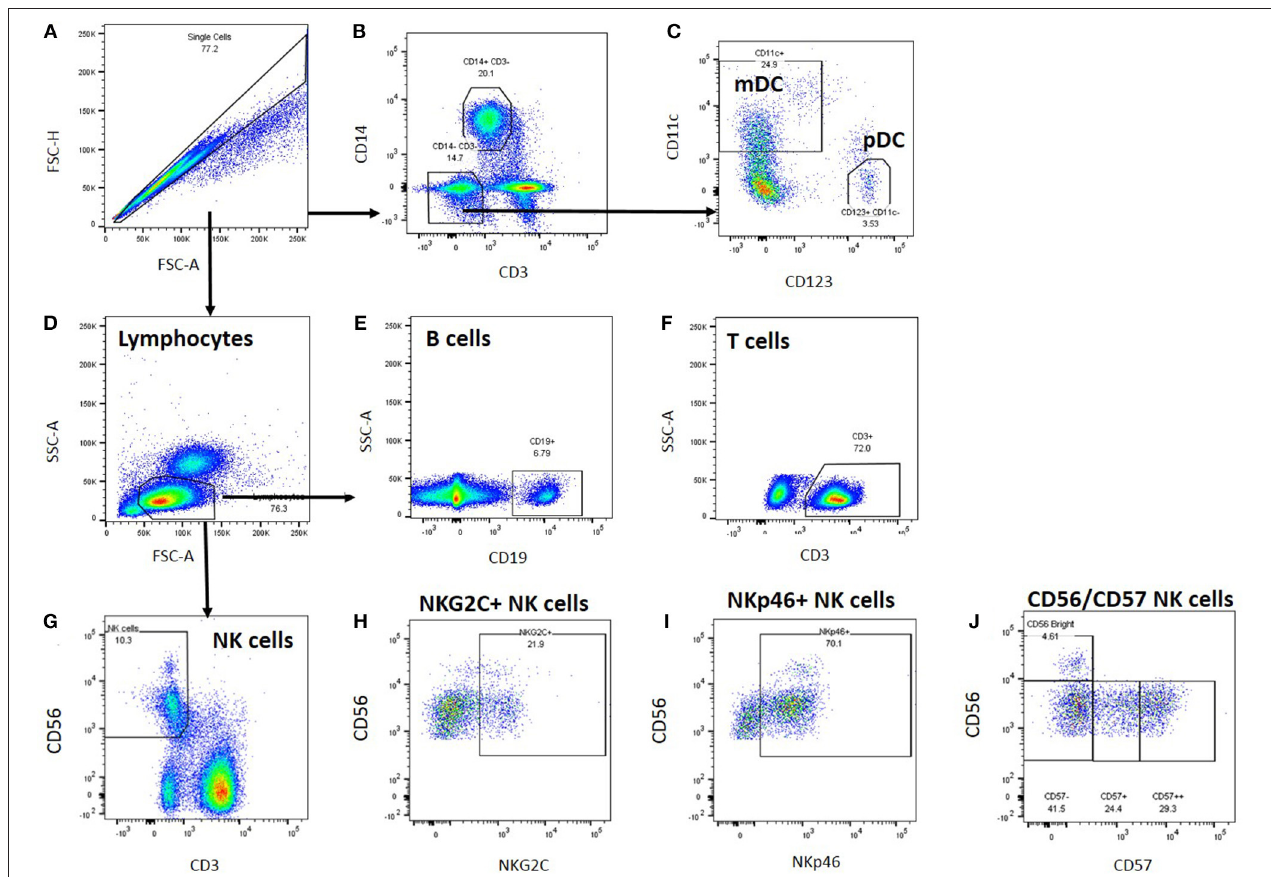
FIGURE 1 | Leucocyte gating strategy for phenotypic characterisation of PBMC. Thawed PBMC from Biobank participants were stained with labelled antibodies ( Supplementary Table S2 ), expression data were collected by Flow cytometry and analysed using FlowJo. (A) Single cells were gated based on their forward scatter height and area, and (B) monocytes within the single cell gate were identified as CD14 + . (C) Dendritic cells were identified within the CD3-CD14- cell population as myeloid (CD11c + ) or plasmacytoid (CD123 + ) DCs. (D) Lymphocytes were identified based on their forward and side scatter area profiles, and B cells were identified as CD19 + (E) , T cells as CD3 + (F), and NK cells as CD56 + (G) . Within the NK cell gate, NK cells were characterised further based on NKG2C (H) , NKp46 (I) , and CD57 (J)